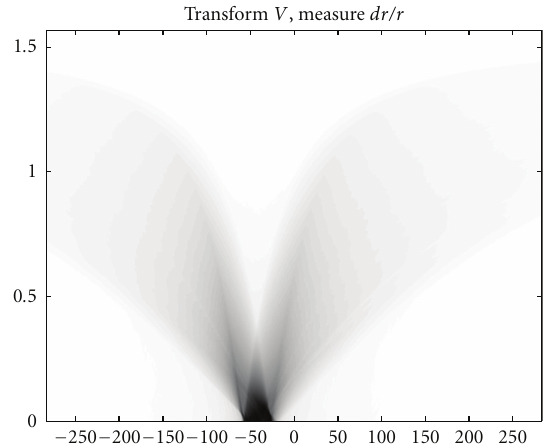
Figure 6: The T V transform of the defect shown in Figure 5 with dω = 0 . 005 rad.